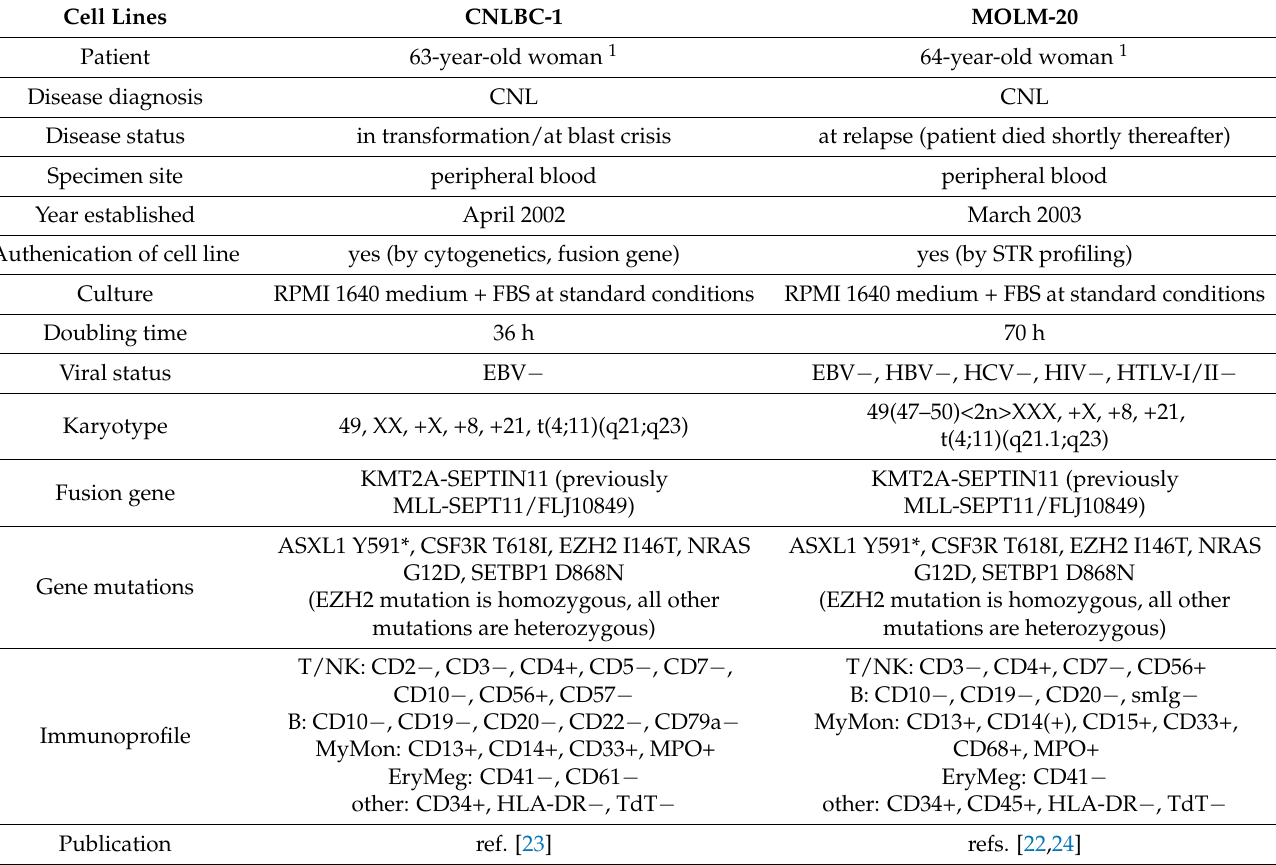
Table 1. Key features of CNL cell lines CNLBC-1 and MOLM-20: clinical, culture, cytogenetic, genomic, and immunopheno- typic